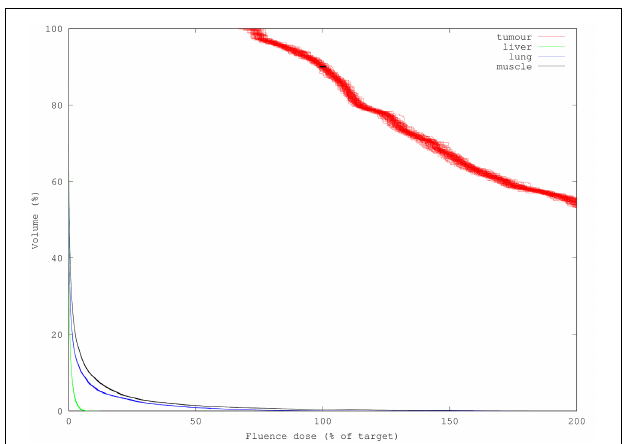
FIGURE 4 | 100 DVHs (100k packets each) overlaid to show result variance; note organs at risk have much lower DVH variance than the target tumor despite having lower fluence. Standard deviation of the D 90 derived from these DVHs is only 1.2% (black bar overlay) despite being composed of high-variance individual results.